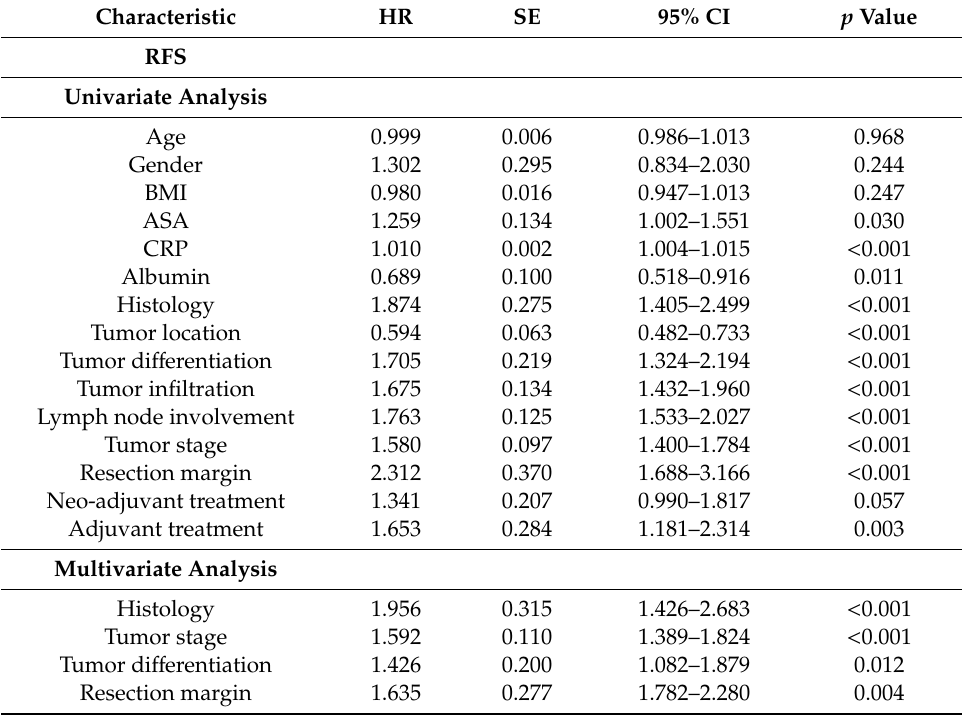
Table 2. Cox regression model analysis for risk factors of postoperative tumor recurrence in 362 patients with esophageal cancer undergoing esophagectomy and reconstruction with gastric pull-up and